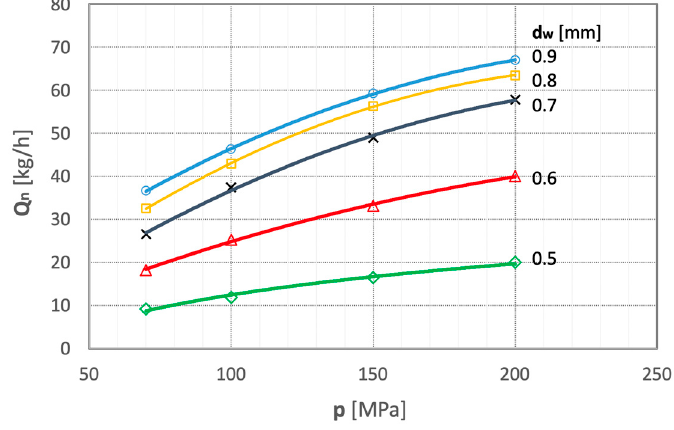
Figure 8. Plots of comminution efficiency of polymetallic nodules as a function of water pressure for several water jets of different diameters (for d h = 2.4 mm and s = 10 mm).